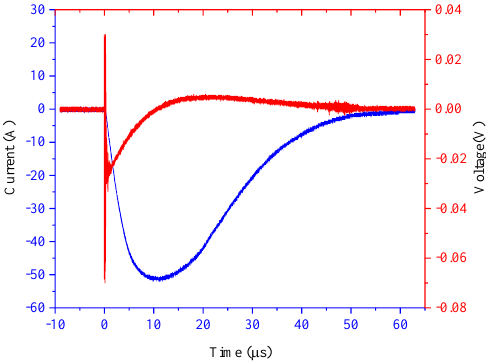
Figure 12. Scene of the lightning surge test.